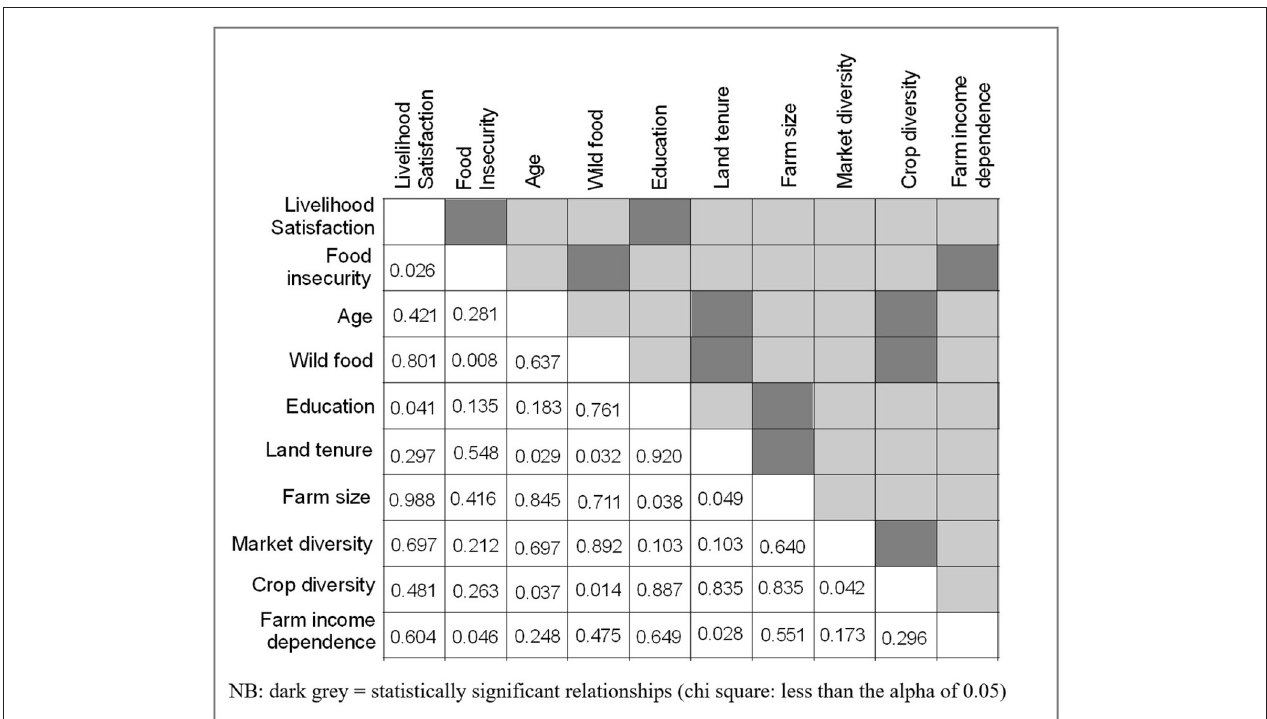
FIGURE 4 | Relationships between food insecurity, wild food harvest, livelihood satisfaction and key socioeconomic and agronomic